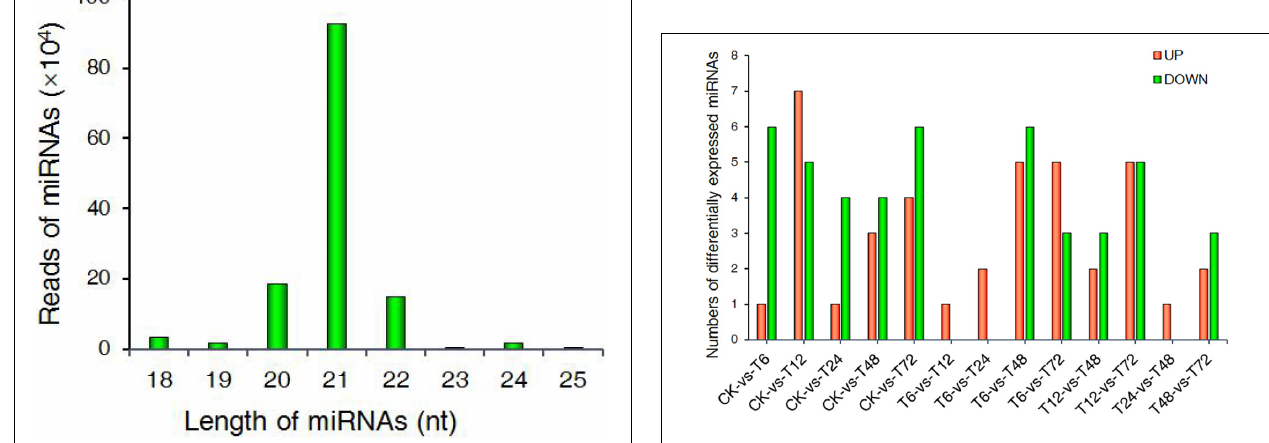
FIGURE 2 | Statistics corresponding to identified miRNAs with different sizes in sugarcane roots.